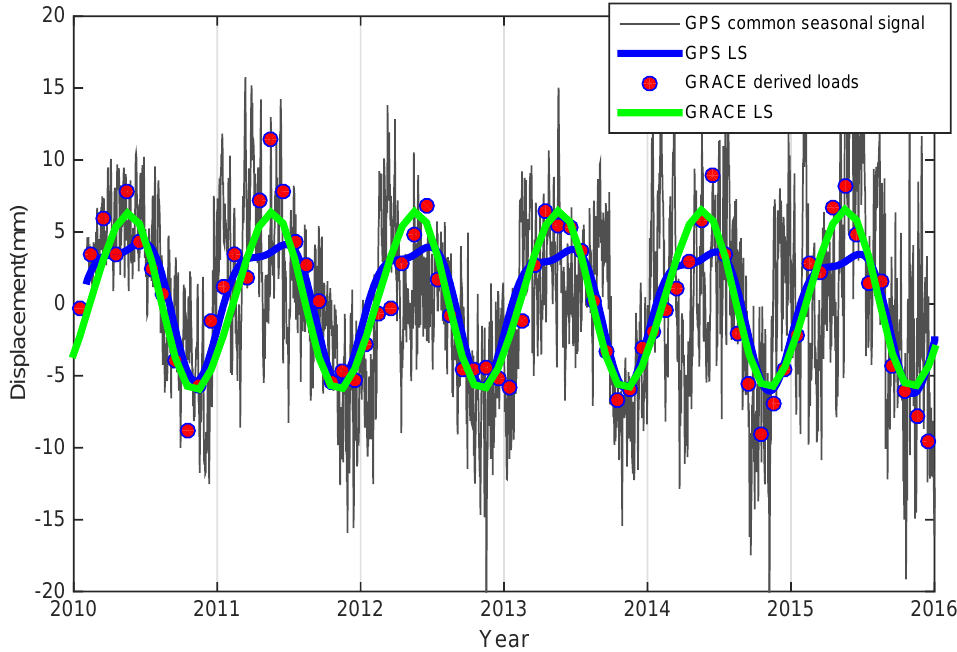
Figure 6. Comparison of empirical orthogonal function (EOF) decomposed first common mode of GPS stations and stacked average GRACE records are from 2010 to 2016. Gray lines (daily solutions) and red dots (monthly solutions) correspond to the GPS and GRACE results, which are fitted by least squares (LS) (i.e., the blue and green lines, respectively).